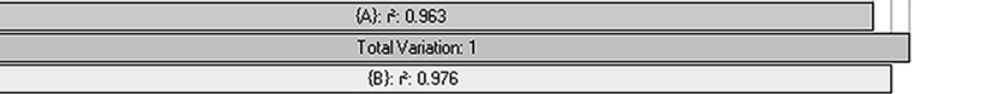
Fig 5. Comparing the effects of climatic and the mid-domain effects on temperate genus diversity by partial regression. A shows the mid-domain effects; B shows climatic effects. Total variance explained by {A} = 0.963; Total variance explained by {B} = 0.976; Total variance explained by {A+B} =